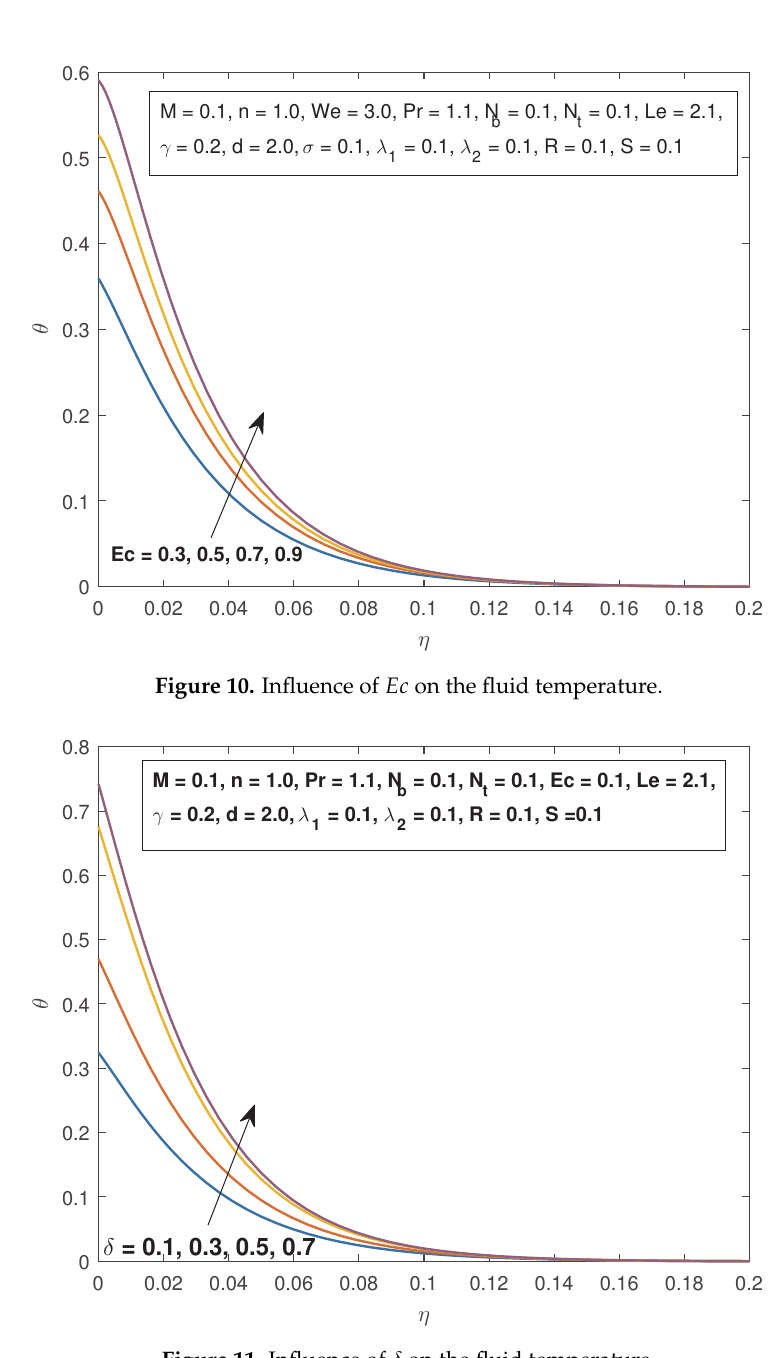
Figure 11. Influence of δ on the fluid